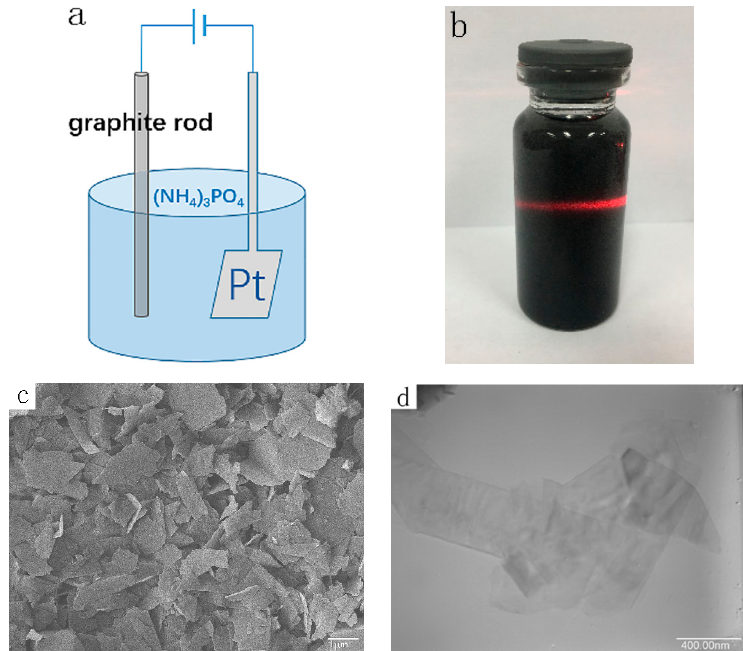
Figure 1. ( a ) schematic diagram of preparation; ( b ) the photo of phosphorus oxide modified graphene (PO-graphene); ( c ) scanning electron microscope (SEM) and ( d ) transmission electron microscopy (TEM) image of PO-graphene.